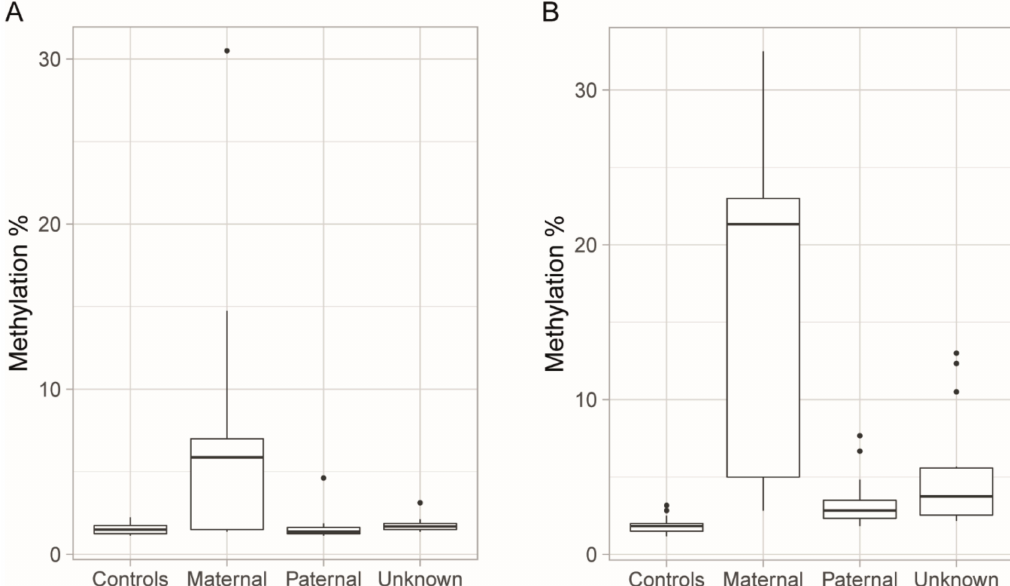
Figure 4. Methylation levels grouped by maternal, paternal, or unknown inheritance. ( A ) Increased methylation of the upstream CpG sites was mainly observed in patients who had inherited the disease allele maternally, while the methylation levels of the patients who had inherited the allele paternally were comparable to those of the controls. ( B ) Increased methylation of the downstream CpG sites was observed in the majority of patients compared to controls, with higher degrees of methylation seen in the patients who had inherited the disease allele maternally. Boxplots indicate medians and quartiles, and the dots indicate the levels of methylation for patients who are outliers.